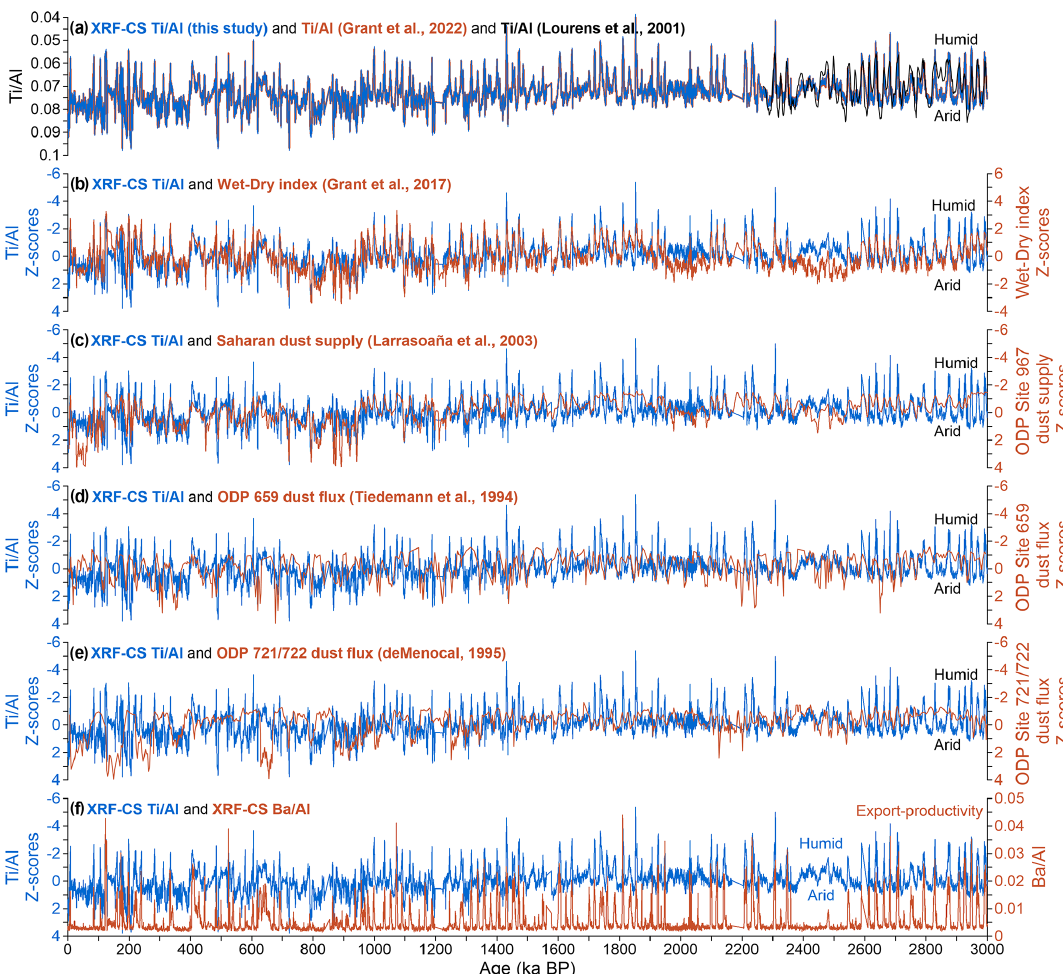
Figure 3. Calibrated Ti / Al record from XRF-CS (this study; blue) and companion records (orange and black). (a) XRF-CS Ti / Al (blue; this study) versus the calibrated XRF-CS data of Grant et al. (2022a) (orange; plotted behind the overlapping blue line) and the WD-XRF values obtained by Lourens et al. (2001) (black). (b) XRF-CS Ti / Al versus the wet–dry index of Grant et al. (2017). (c) XRF-CS Ti / Al versus Saharan dust supply (Larrasoaña et al., 2003). (d) XRF-CS Ti / Al versus ODP Site 659 dust flux (Tiedemann et al., 1994). (e) XRF-CS Ti / Al versus ODP Site 721/722 dust flux (DeMenocal, 1995, 2004). (f) XRF-CS Ti / Al versus calibrated XRF-CS Ba / Al. Ti / Al and dust records in (b–f) are normalized (i.e., presented as z scores by subtracting the average and dividing by the standard deviation over the same 3-million-year interval) to facilitate